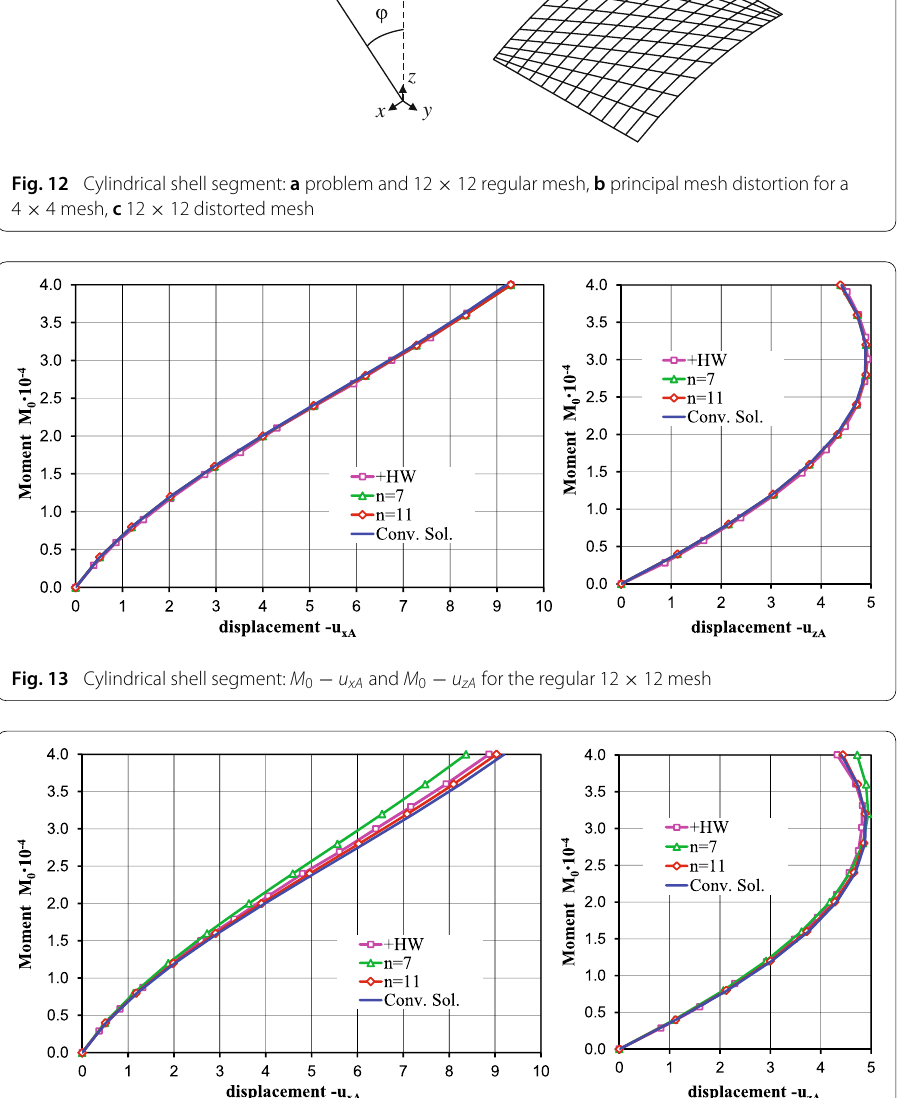
Fig. 14 Cylindrical shell segment: M 0 − u xA and M 0 − u zA for the distorted 12 × 12